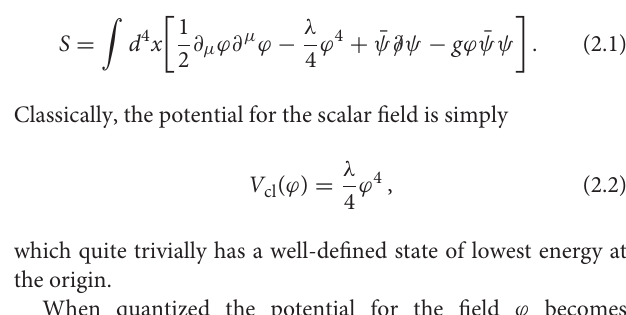
If the Universe was infinitely old, even an arbitrarily low vacuum decay rate would be incompatible with our